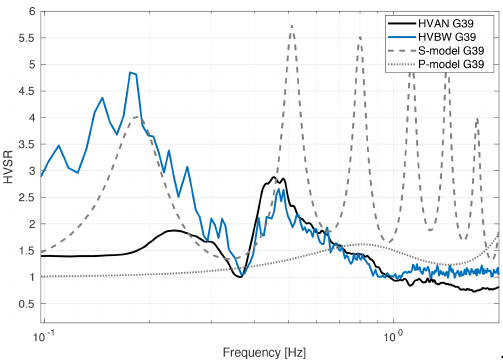
Figure 12. Modelled shear-wave resonance (dashed line), compressional-wave resonance (dotted line), HVAN (black solid line) and HVBW (blue solid line) for the 50m depth seismometer of station G39. The HVBW is taken as the mean over five teleseismic phases (Table